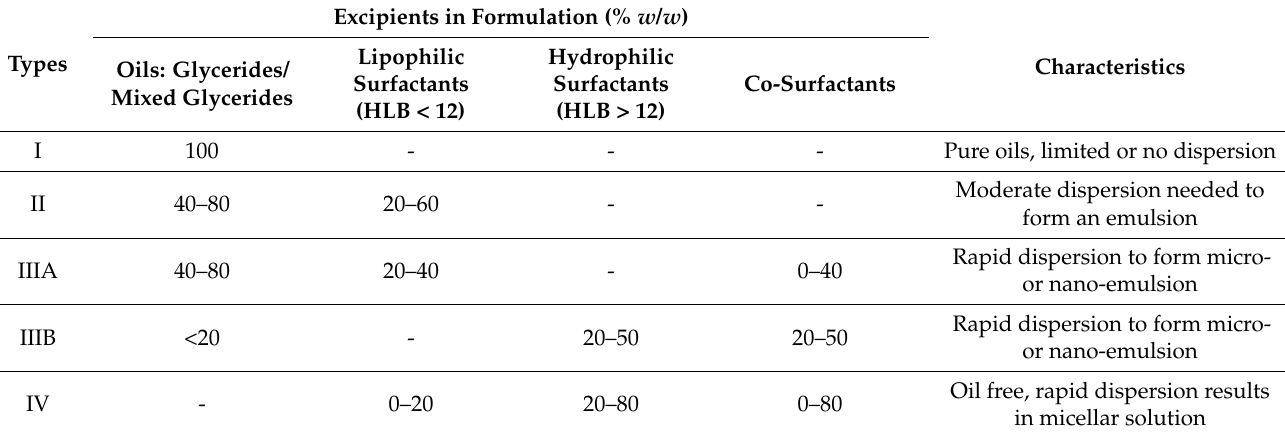
Table 1. Lipid classification systems, reprinted with permission from [13], Taylor & Francis,